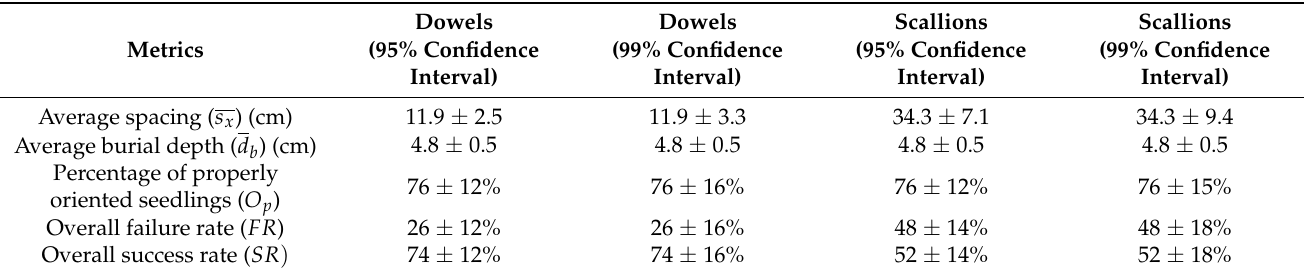
Figure 14. Onions transplanted during testing. Table 7. Testing results of the transplanter prototype.